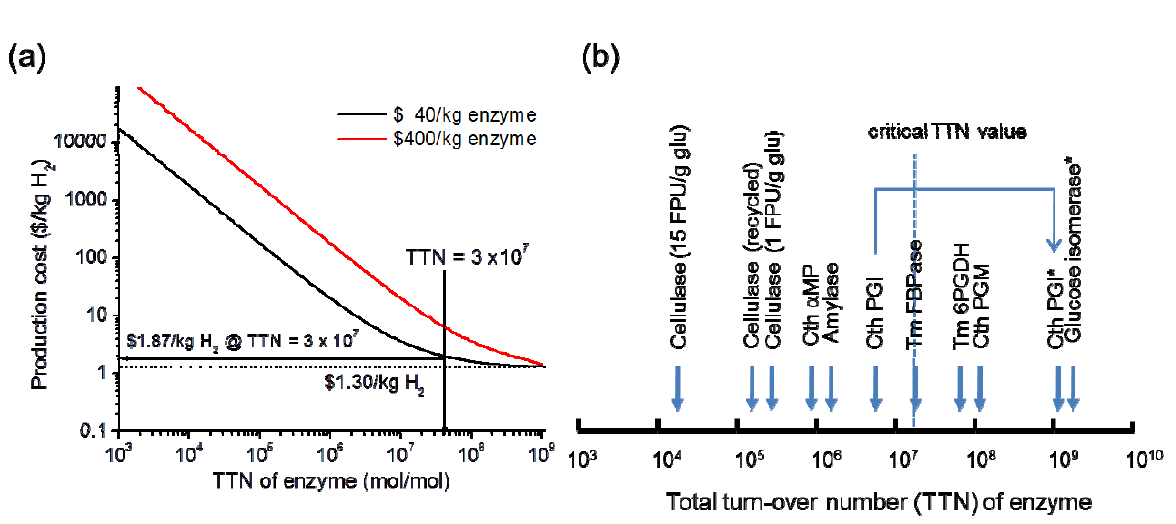
Figure 9. Cost analysis of hydrogen production in terms of TTN values of the enzymes ( a ) and typical total turn-over number (TTN) values of enzymes ( b